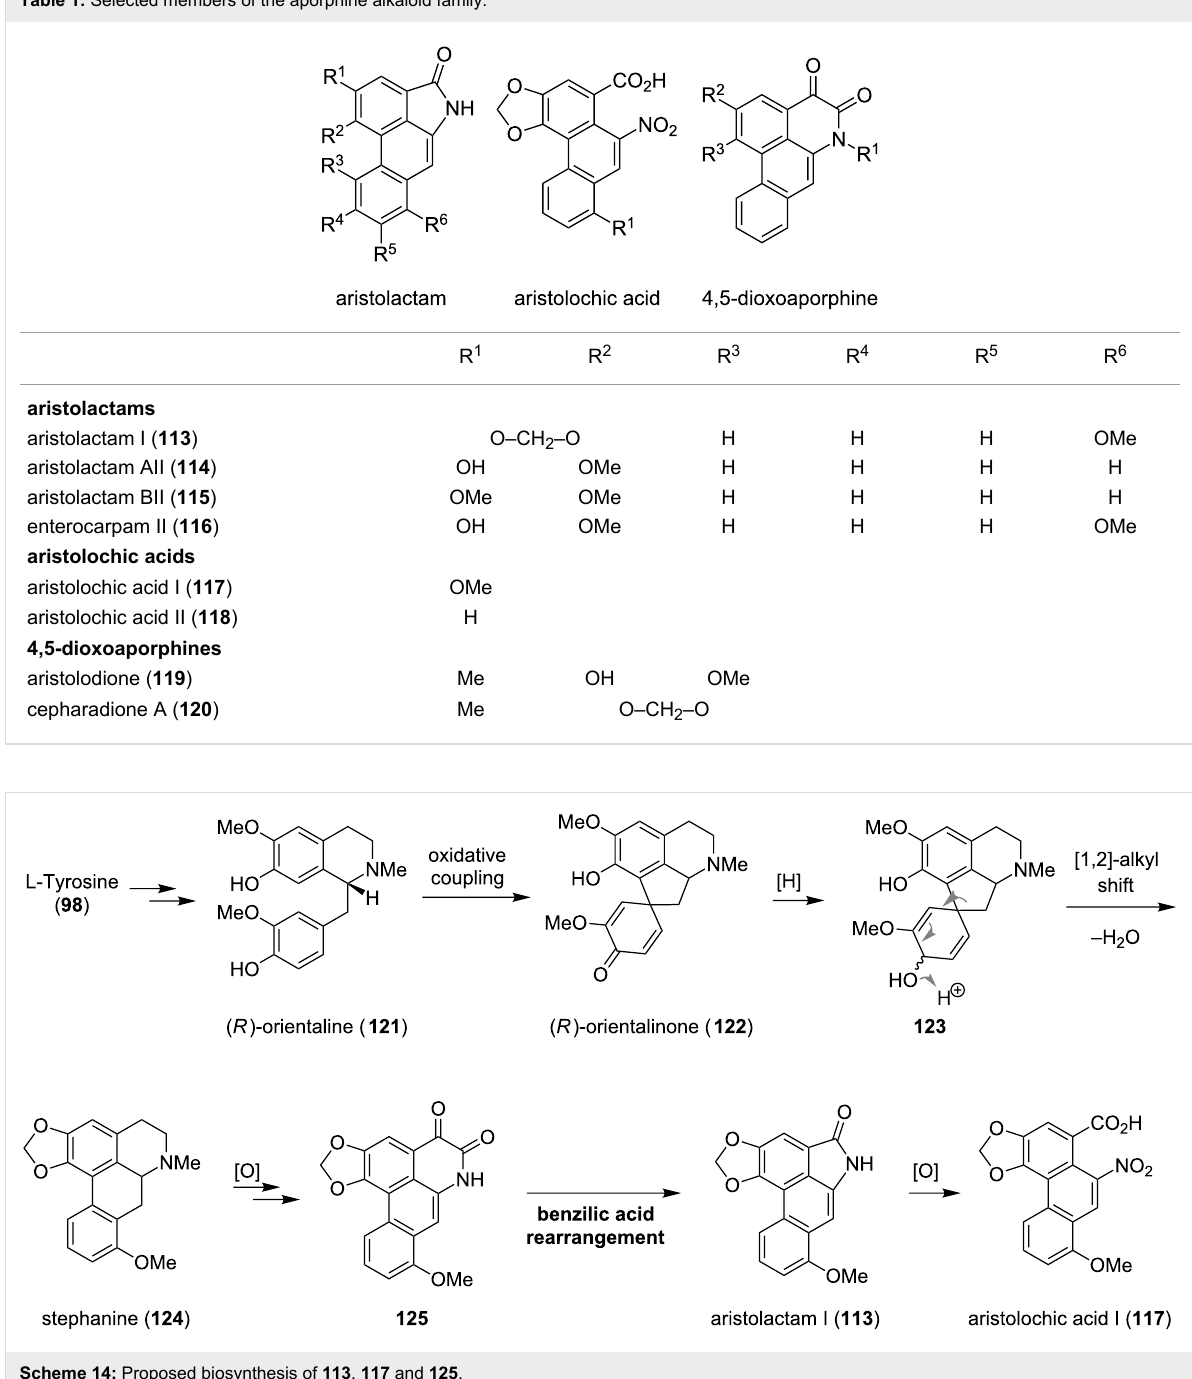
cytotoxic activities and inhibitory effects on platelet